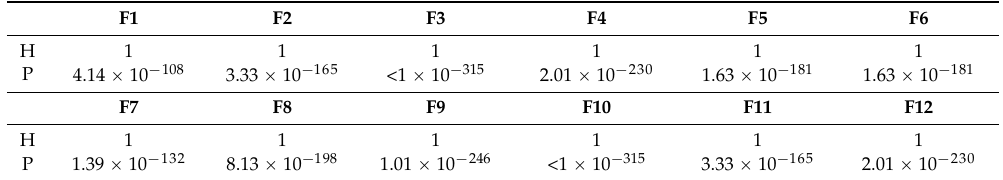
Table 5. Wilcoxon signed-rank test results for OAFWA and AFWA.